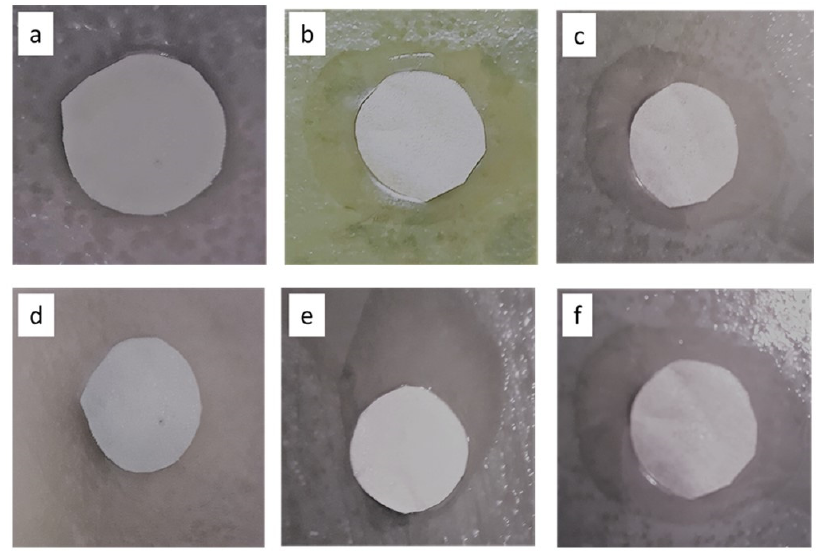
Figure 10. Inhibition zones of ( a ) CEM-3.5, ( b ) CEM-Ag3, ( c ) CEM-Cu3, ( d ) AEM-3.5, ( e ) AEM-Ag3, and ( f ) AEM-Cu3 membranes.